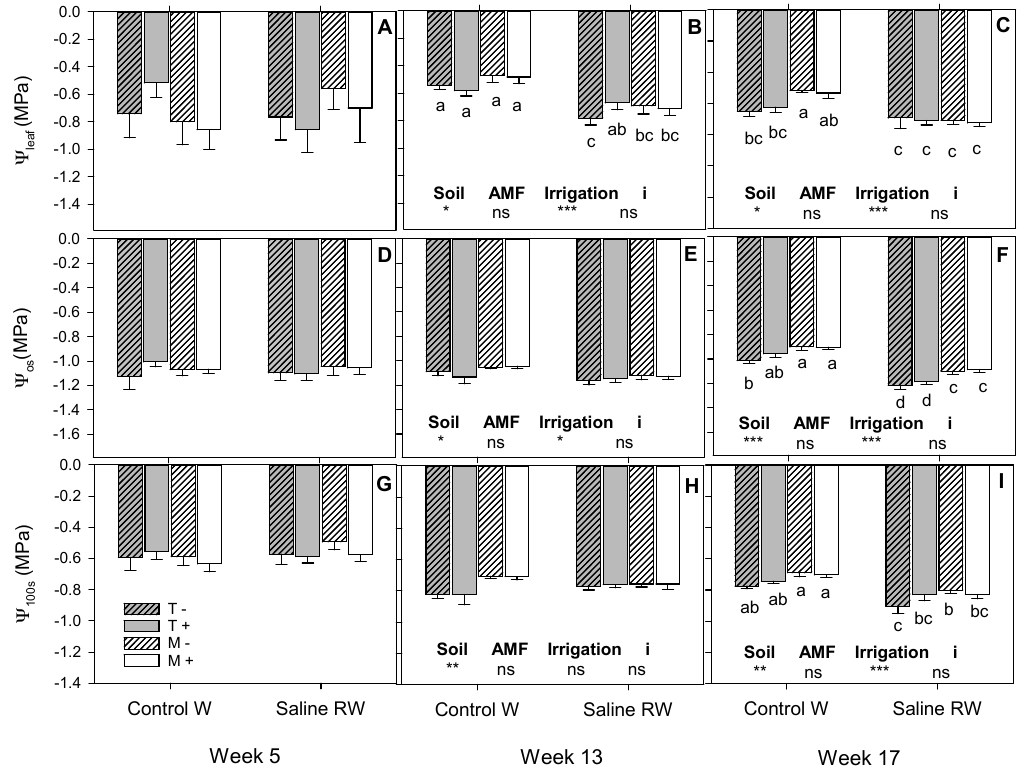
Figure 3. Leaf water potential ( Ψ leaf ) ( A , B , C ), osmotic water potential ( Ψ os ) ( D , E , F ) and osmotic water potential at full turgor ( Ψ 100s ) ( G , H , I ) in plants irrigated with control water (Control W) and saline reclaimed wastewater (Saline RW) growing in traditional soil (T) or mixed substrate (M) without ( − ) and with AMF ( + ) inoculation, at weeks 5, 13 and 17. Results of one way and three-way ANOVA tests in these parameters, for independent variables (soil, AMF and irrigation) and their interaction (i). Di ff erent lowercase letters indicate significant di ff erences between treatments according to Duncan’s test at p ≤ 0.05. * p < 0.05, ** p < 0.01 and *** p < 0.05. p > 0.05 non-significant di ff erences are indicated by “ns”.